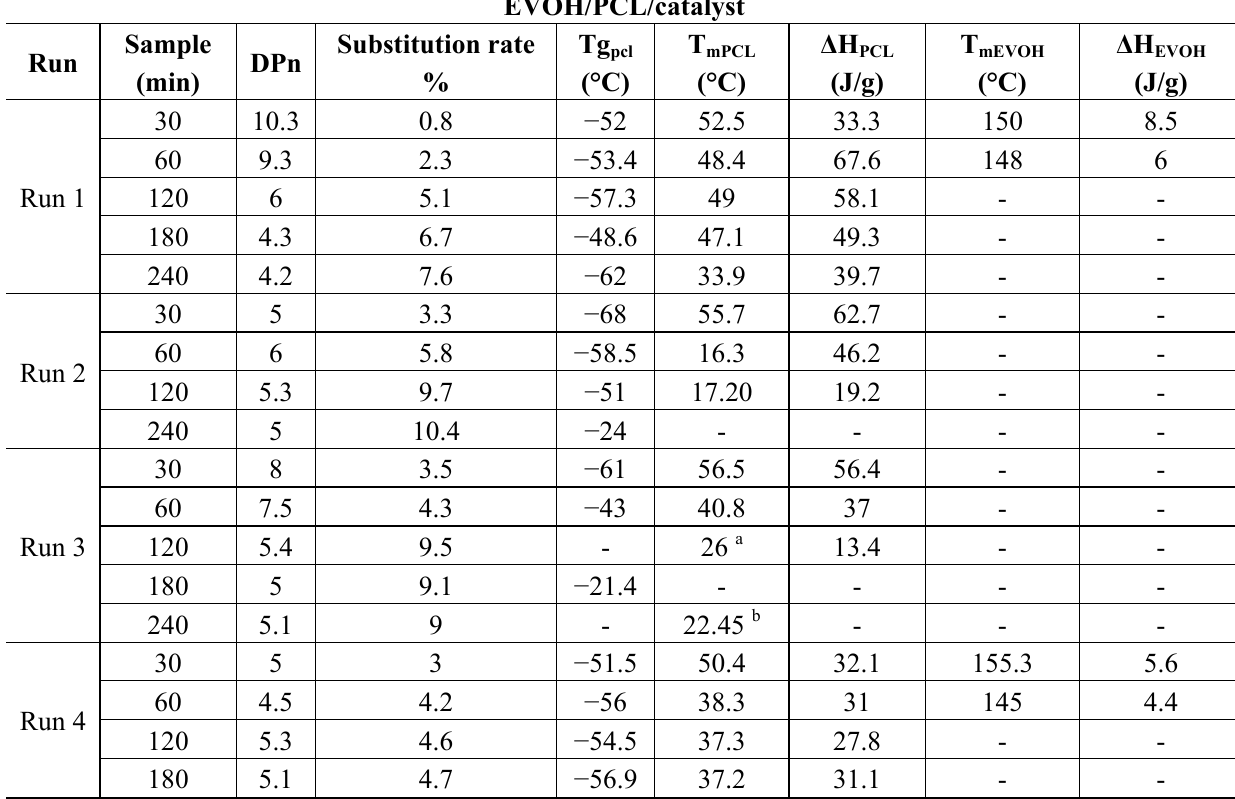
Table 2. Thermal transitions obtained by differential scanning calorimetry (DSC) and substitution rates calculated from 1 H RMN analysis (solvent = DMSO- d temperature = 90